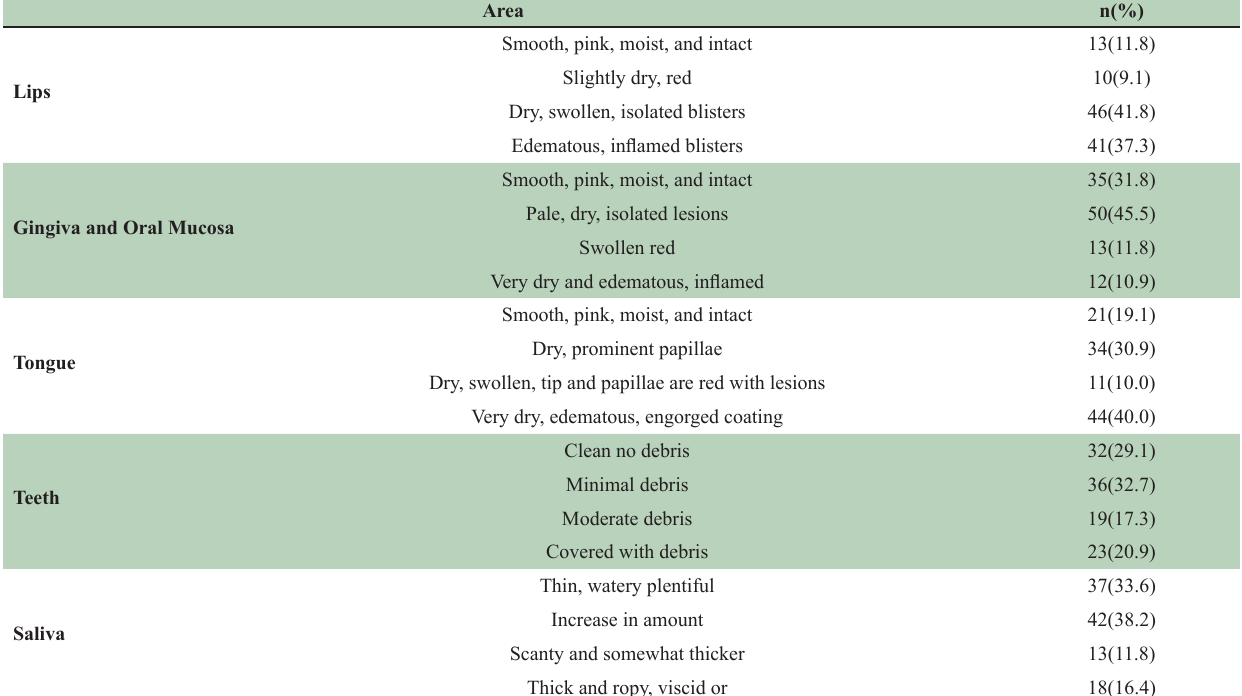
Table–II: Area of Beck oral assessment scale (BOAS).